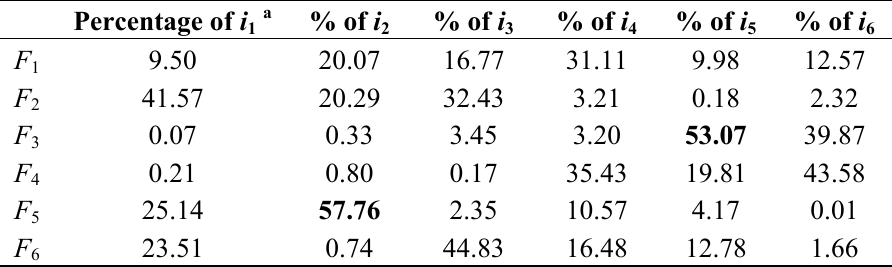
Table 5. Profile of the principal component analysis factors for the vector property of pesticides.